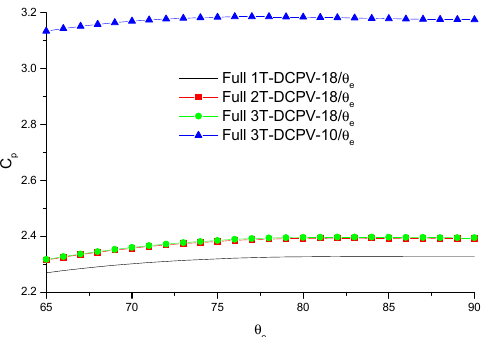
Figure 27. Effects of θ e on annual power output increase factor of full θ on annual power output increase factor of full DCPVs. Figure 27 . Effects of e